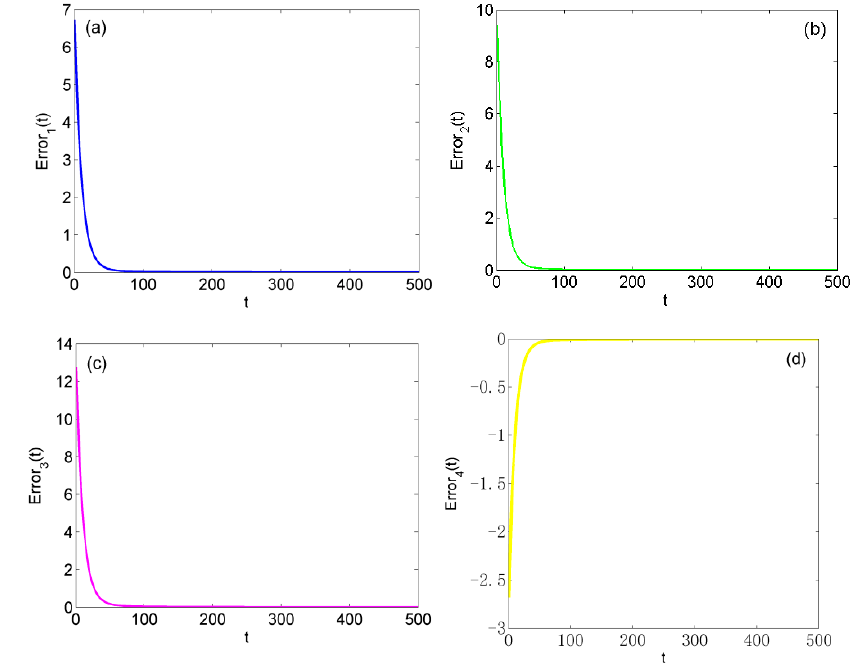
Figure 7. Error plots: ( a ) Error 1 ( t ) ; ( b ) Error 2 ( t ) ; ( c ) Error 3 ( t ) ; ( d ) Error 4 ( t ) .